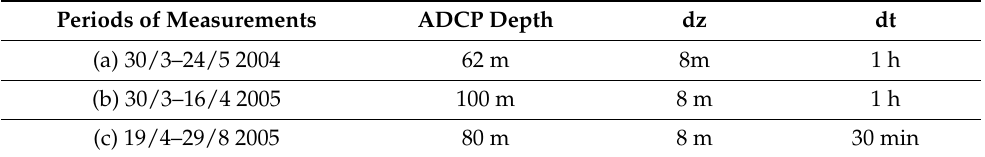
Figure 13. Progressive vectors at each cell ( a ) and a zoom ( b ) on a sub-sample dominated by inertial variability. The two time series of 2005 were merged after hourly averaging the time series sampled at 30 min. The resulting time series (bc) covers the correspondent period of the 2017, apart from 38 h of missing data which were replaced by a constant value in order to preserve the temporal evolution. Basic statistics are reported in Table 3. Table 2. Period of measurements and settings of the ADCP measurements used for the comparison.